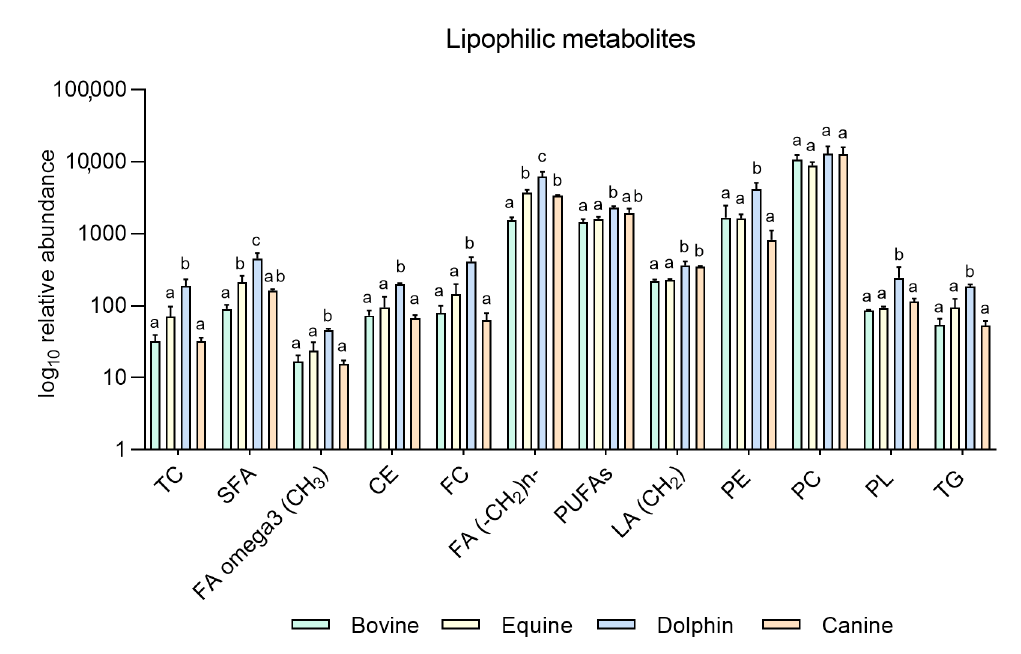
Figure 2. Metabolites identified in the lipophilic phase of bovine, equine, dolphin and canine sperm extracts by NMR spectroscopy. a,b,c Different letters indicate significant differences ( p < 0.05) among species for each metabolite. Total cholesterol (TC), saturated fatty acids (SFA), fatty acids omega 3 (CH 3 ) (FA omega3), cholesterol ester (CE), free cholesterol (FC), fatty acids (-CH 2 )n- [FA (-CH 2 )n-], polyunsaturated fatty acids (PUFAs), linoleic acid (CH 2 ) [(LA(CH 2 )], phos- phatidylethanolamine (PE), phosphatidylcholine (PC), phospholipids (PL), triglycerides (TG). Bovine and dolphin data were already published [60], equine and canine data belong to this new